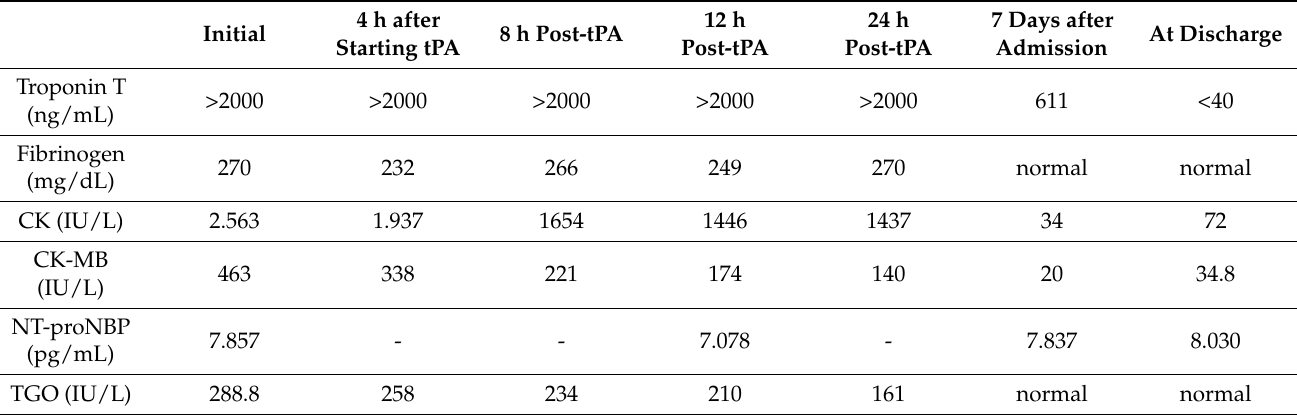
Table 2. Laboratory results (tPA: tissue plasminogen activator).